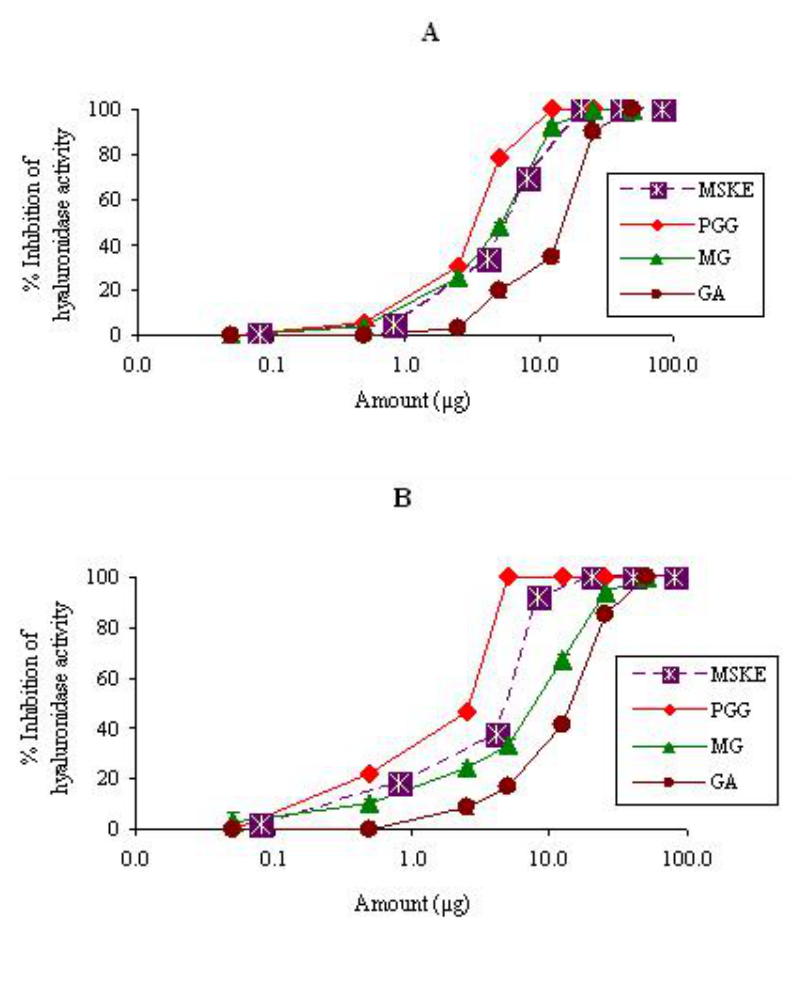
Figure 2. Semi-log plot of inhibition of hyaluronidase activity of CR (250 µg) (A) and NK (250 µg) (B) venoms by MSKE and its phenolic principles (GA, MG and PGG). Values are mean ± S.E.M. of duplicate